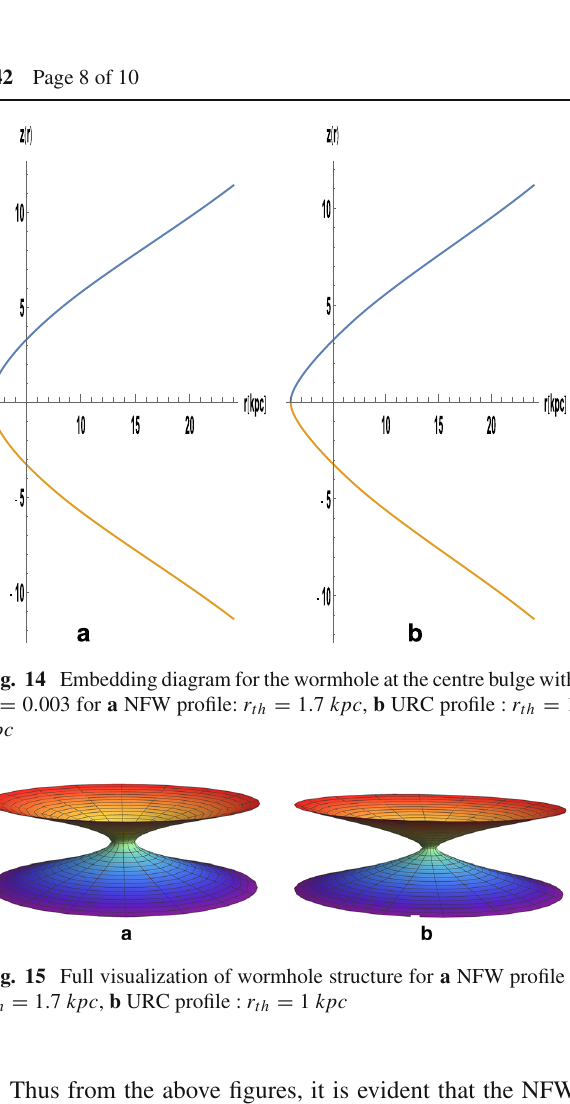
Fig. 15 Full visualization of wormhole structure for a NFW profile : r th = 1 . 7 kpc , b URC profile : r th = 1